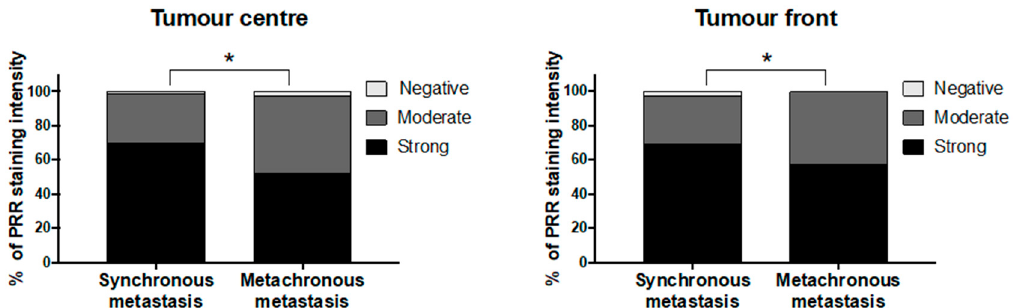
Figure 3. PRR protein expression according to the metastatic relapse time of CRC patients. PRR staining intensity was scored as negative, moderate or strong. The scores were quantified in each tissue group and statistical significance of the PRR intensity pattern among the different tissues was determined by Chi-Square test. (*) p < 0.05.